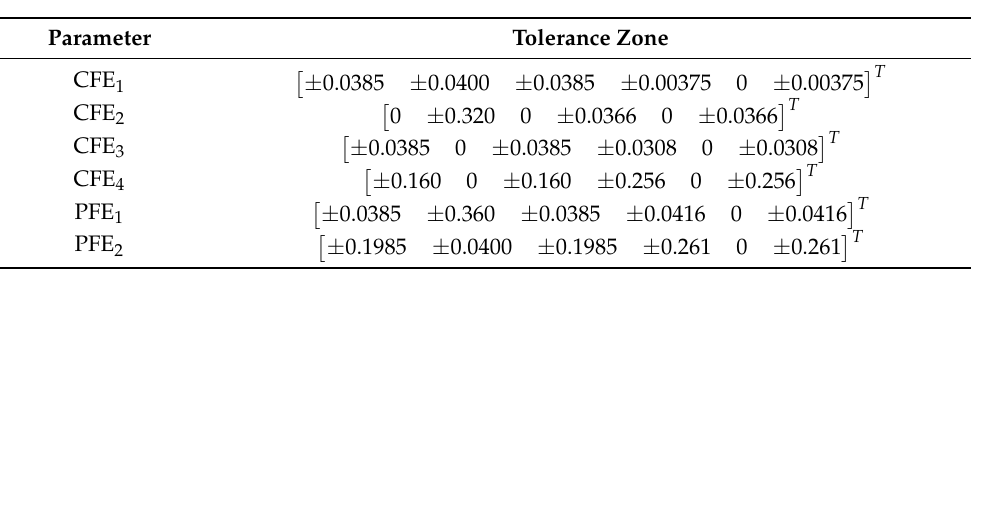
Table 1. Variations of torsor models of the thread-fastening